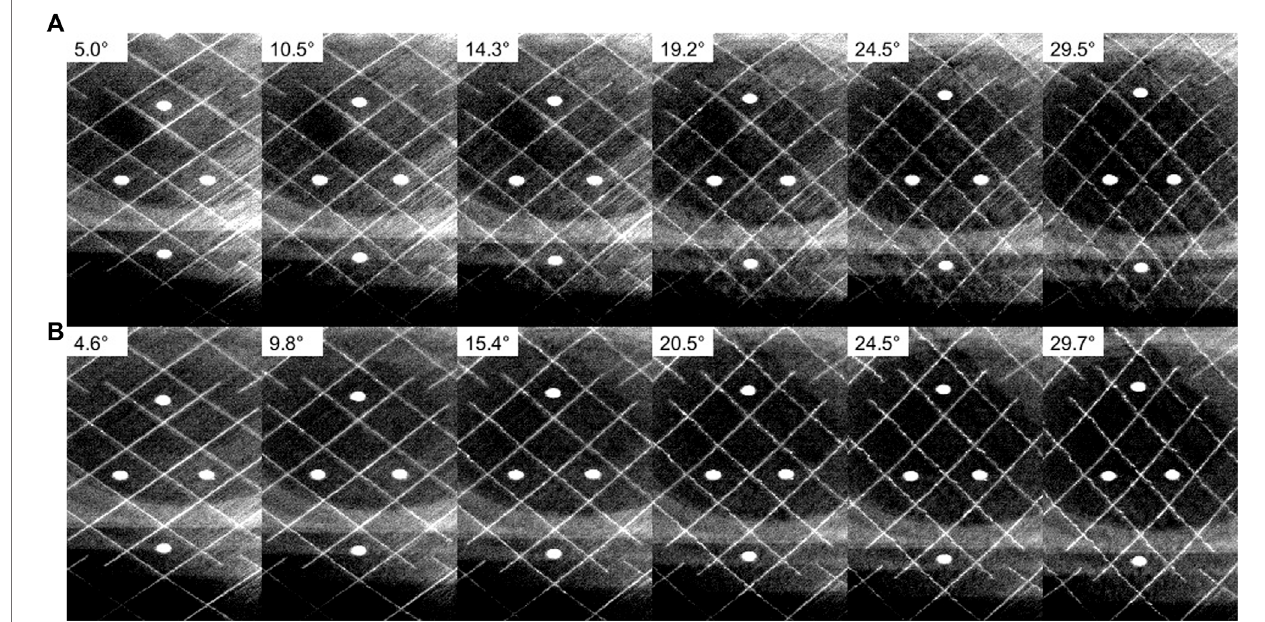
FIGURE 10 | Post-processed footage from the video extensometer throughout the bias extension test to enable the visual inspection of the onset of localization. The jagged lines indicate the localization of shear deformation along the fi ber direction of the outer ply. (A) Solvay APC 345 ° C 100 mm/min. (B) Toray TC1225 345 ° C 100 mm/min.